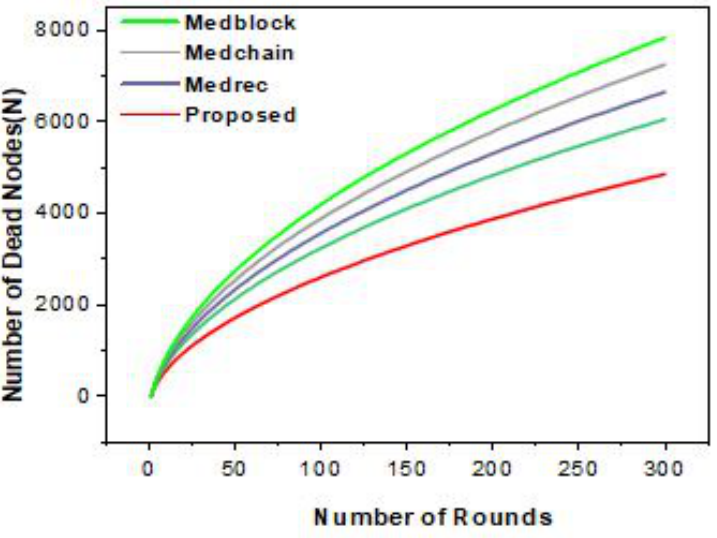
Figure 7. Comparative analysis of concurrent requests for the proposed